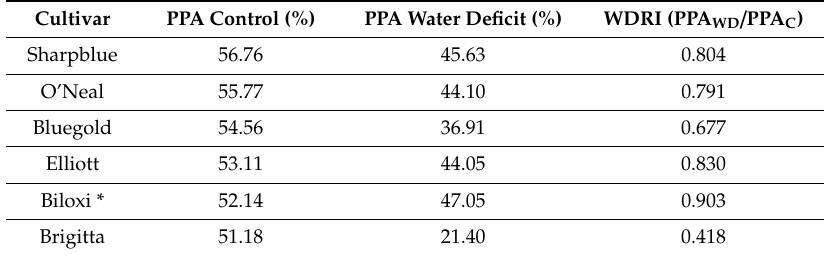
Table 2. Physiological plant activity and water deficit resistance index (%) calculated using the proposed model (3,4) measured at week 6 after drought stress treatment (RWC, F v / F m , and δ 13 C). * indicates best performing cultivar under